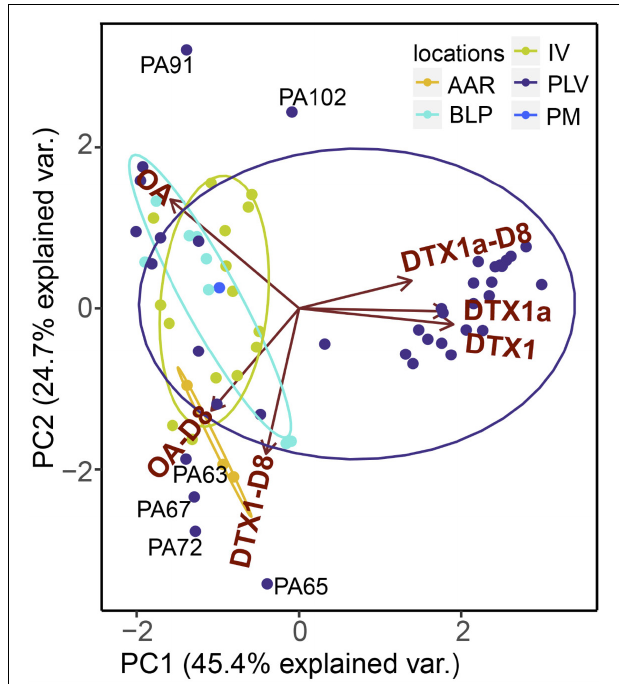
FIGURE 6 | Principal component analysis and ordination of Prorocentrum isolates ( n = 67) along the first and second PC axes representing 70.1% of the observed variance with relative toxin composition as explanatory variables. Samples are color-coded to reflect grouping by locality of